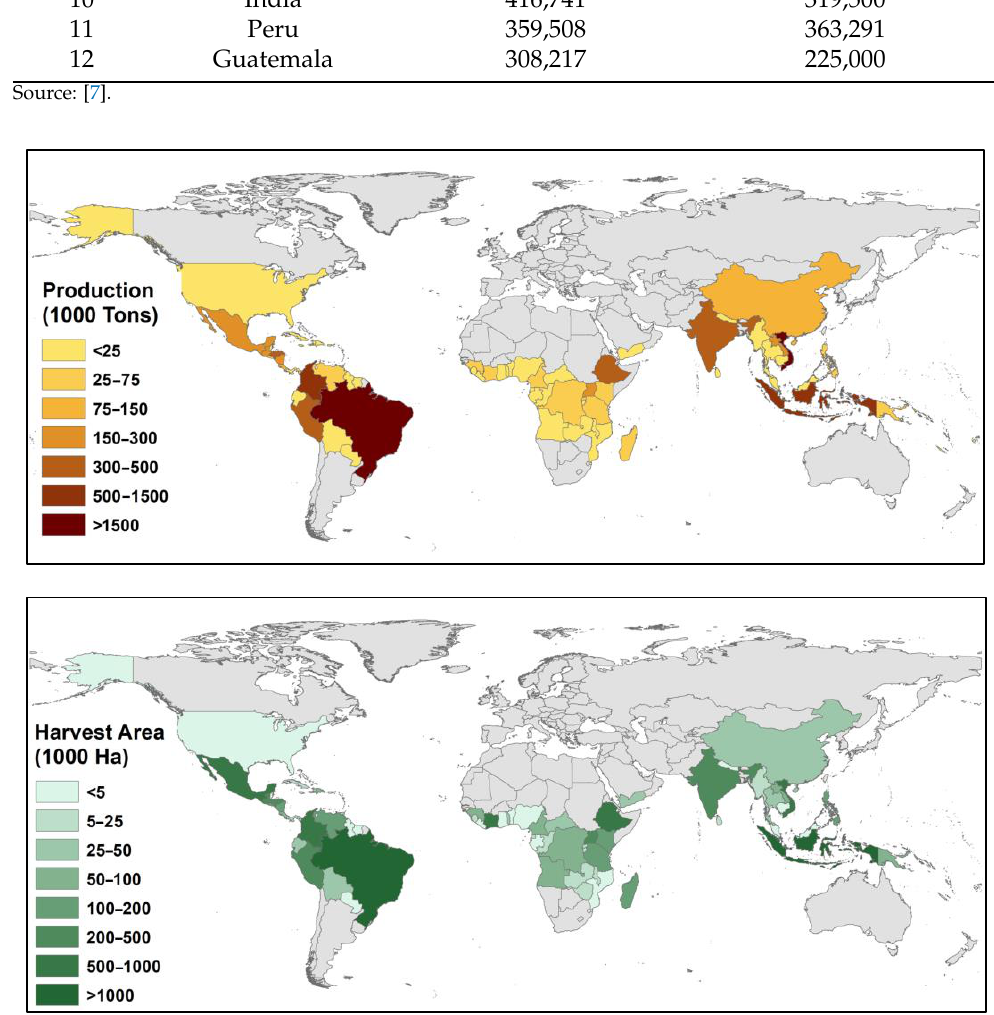
Figure 1. World coffee production ( top ) and harvested area ( bottom ) in 2019 [7].